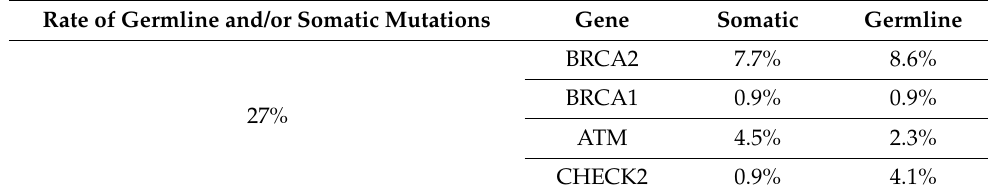
Table 2. Prevalence of DDR gene mutations in